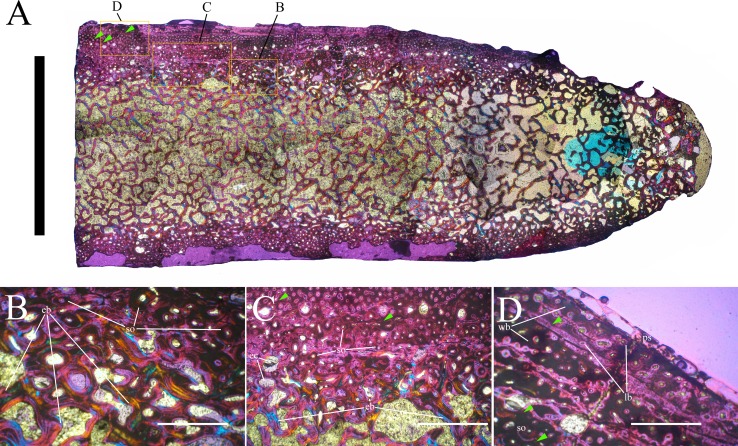
MSNVE 3714, apex neural spine of dorsal vertebra 14, transverse thin section.Panoramic view of the cranial half of the section; note how the compact cortex becomes thinner trending through the top of the neural spine (A); detail of the Haversian systems in the inner most cortex and endosteal bone (B); gradual transition between the compacta and the medullary cortex (C; note the erosional cavities and deep remodeling of the primary bone); detail of the outer cortex with outermost LAGs but without an EFS (D). Abbreviations: eb, endosteal bone; ec, erosional cavities; lb, lamellar bone; ps, periosteal surface; so, secondary osteons; wb, woven bone. Green arrows point to the LAGS. Scale bars equal 10 mm in A and 1 mm in B–D.